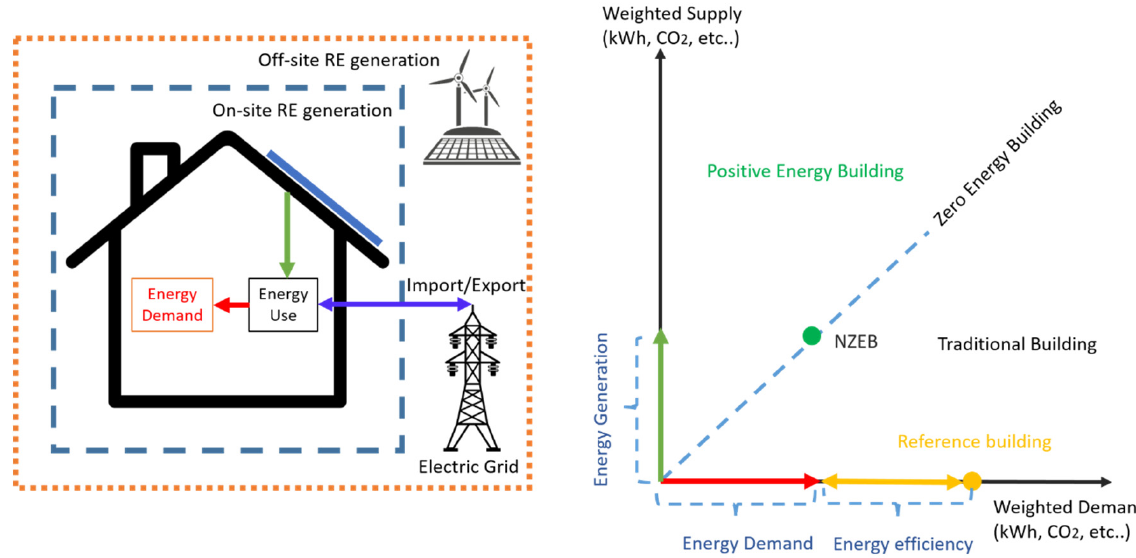
Figure 4. Brief schematic of the Positive Energy Building Concept. Partially reprinted with the permission from [67].